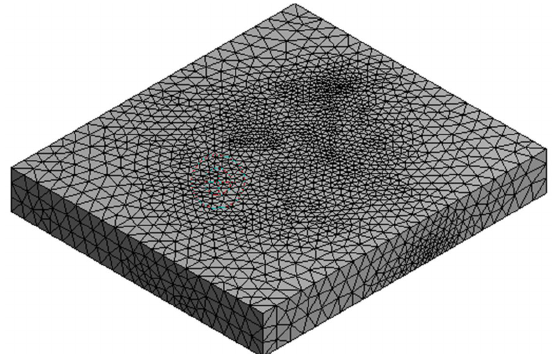
Figure 13. The effect of model discretization—computational grid.